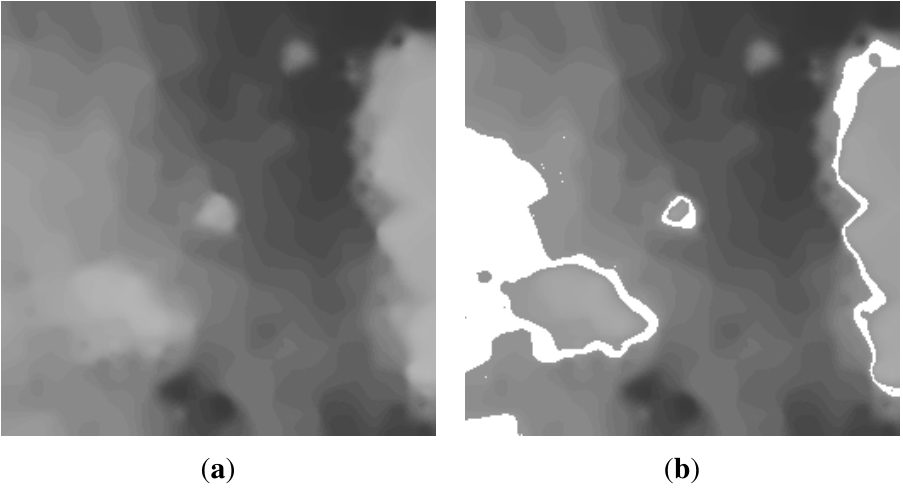
Figure 7. ( a ) Field generated from 600 nodes randomly distributed on the surface of the 2D map in Figure 6a; ( b ) A contour at 116 units drawn on the mapped field in ( a